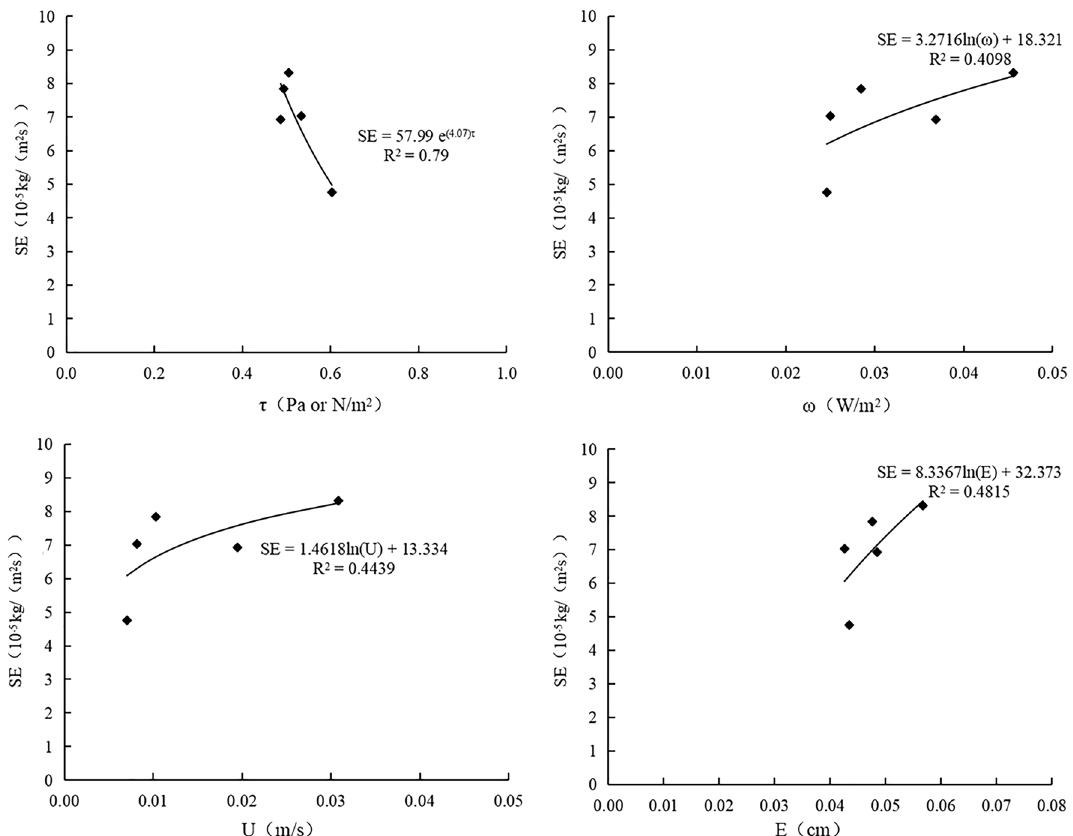
Figure 6. Variations of sheet erosion rate of Prunella vulgaris planting slope with hydraulic parameters. O is bare slope, B is Prunella vulgaris combined with earthworm planting slope, A is Single planting prunella vulgaris